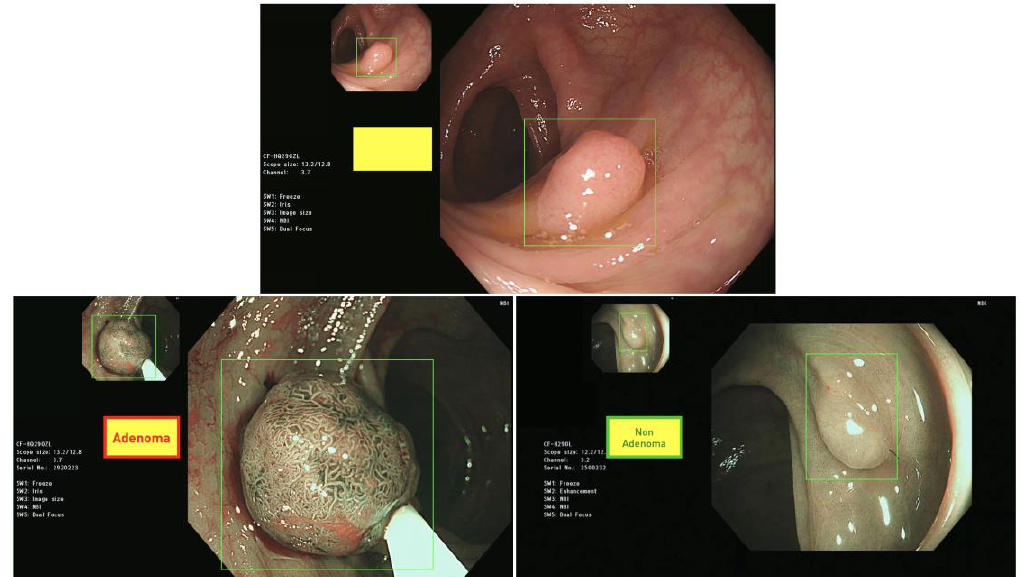
Figure 2. Demonstration of the EndoAIM TM system using testing